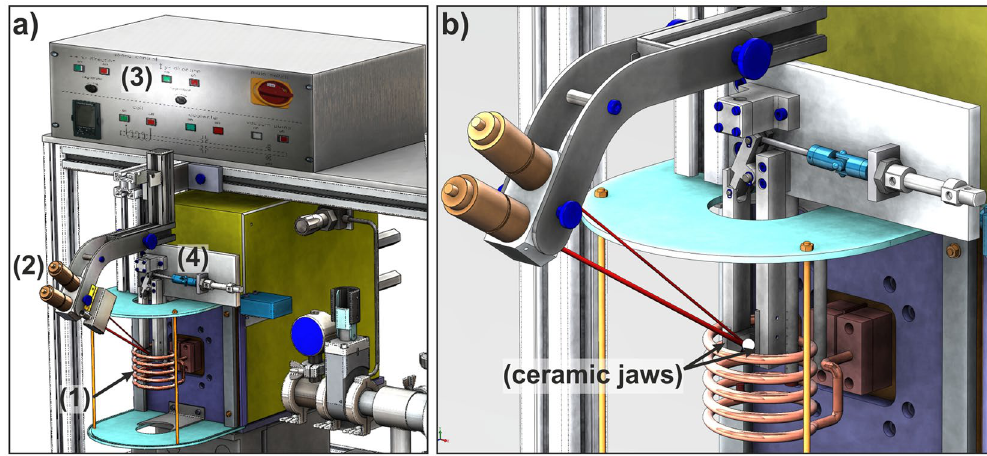
Figure 1. Setup of the flash-annealing device. ( a ) The BMG specimen is located within the water-cooled induction coil (1) and a high-speed pyrometer (2) records its surface temperature. When a pre-defined temperature is reached, the control unit (3) activates the clamping system (4), so that the specimen falls into a water-bath (not shown here), which is placed inside the coil directly below the specimen. ( b ) Magnification of the induction coil including the clamping system. The sample is located between two ceramic jaws (indicated by black arrows) and a white spot marks its